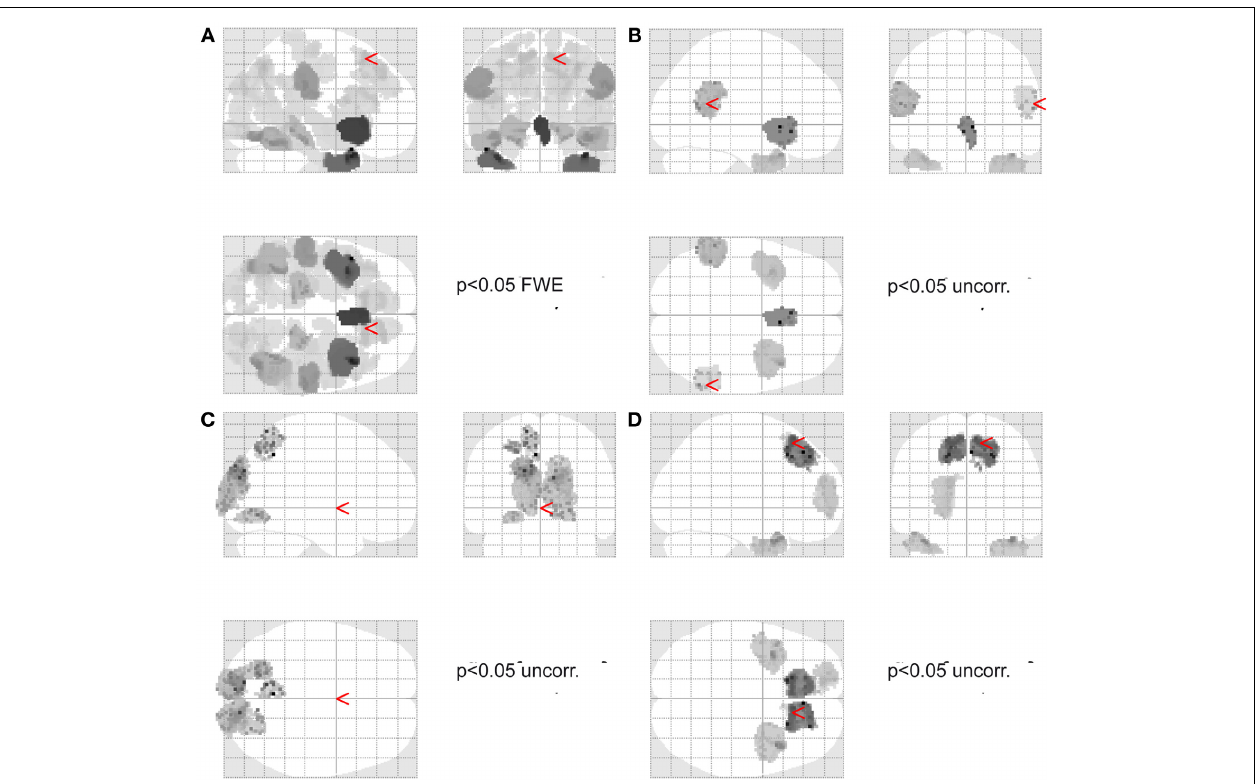
FIGURE 2 | Source localization. (A) Shows the main effect across all conditions ( p < 0 . 05 FWE corrected for multiple comparisons). Red arrow points to the location used for the DCM analysis for the preSMA source. (B) Shows the main effect of agency ( p < 0 . 05 uncorrected threshold). Red arrows point to the location used for the DCM analysis